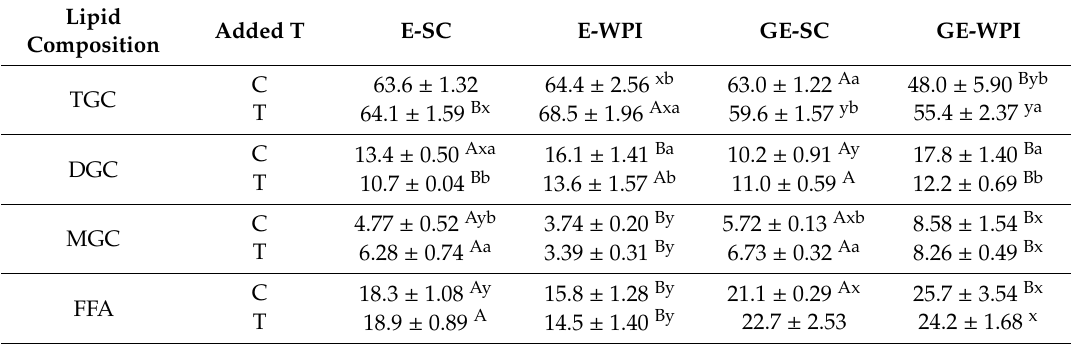
Table 4. Lipid composition after in vitro digestion of liquid-like and gelled emulsions (Es and GEs). as a function of emulsifying protein (EP), condensed tannins (T) incorporation and cold gelation. Lipid Added T E-SC E-WPI Composition